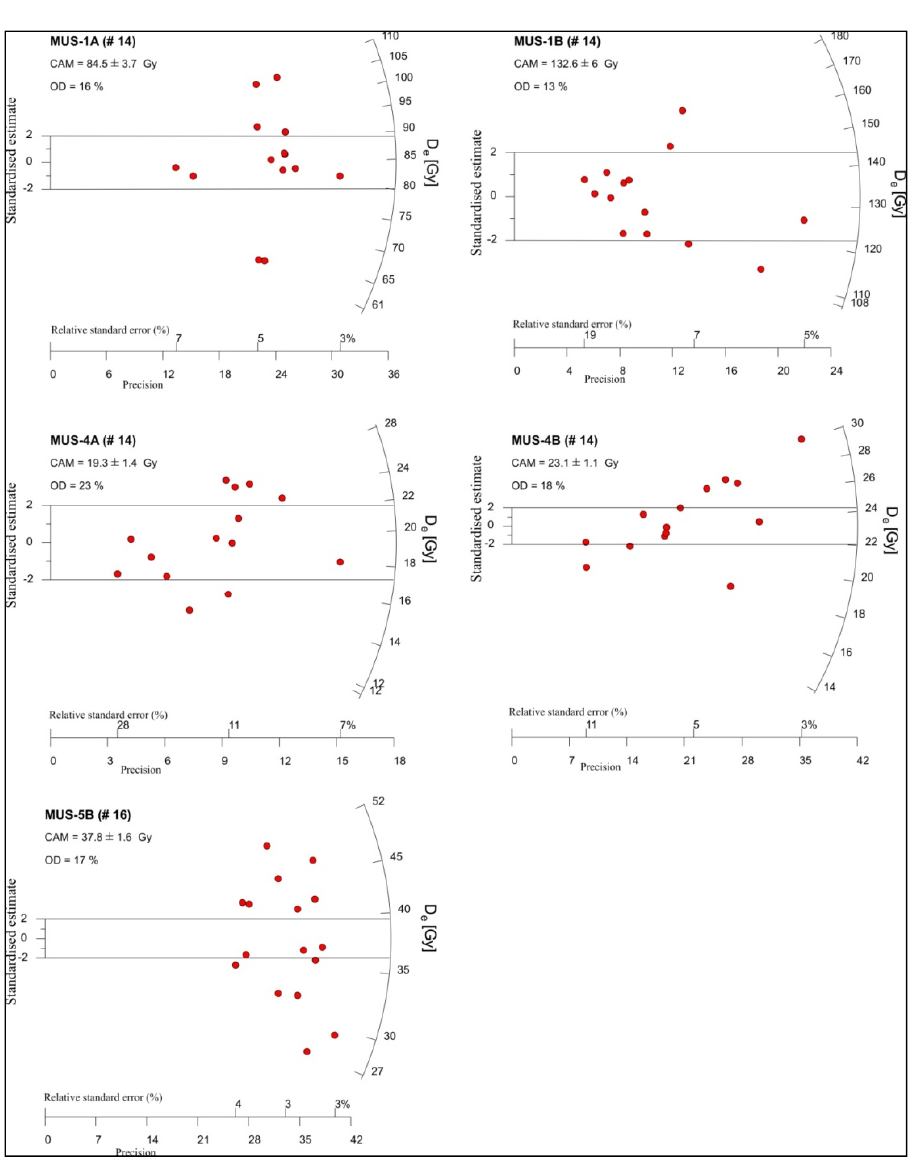
Figure 5. Radial distributions of EDs yielded (<2) after measuring 14–16 aliquots for each sample. The values with associated for individual aliquots are seen. The Central Age Model (CAM) was used in order to evaluate the corresponding ages.